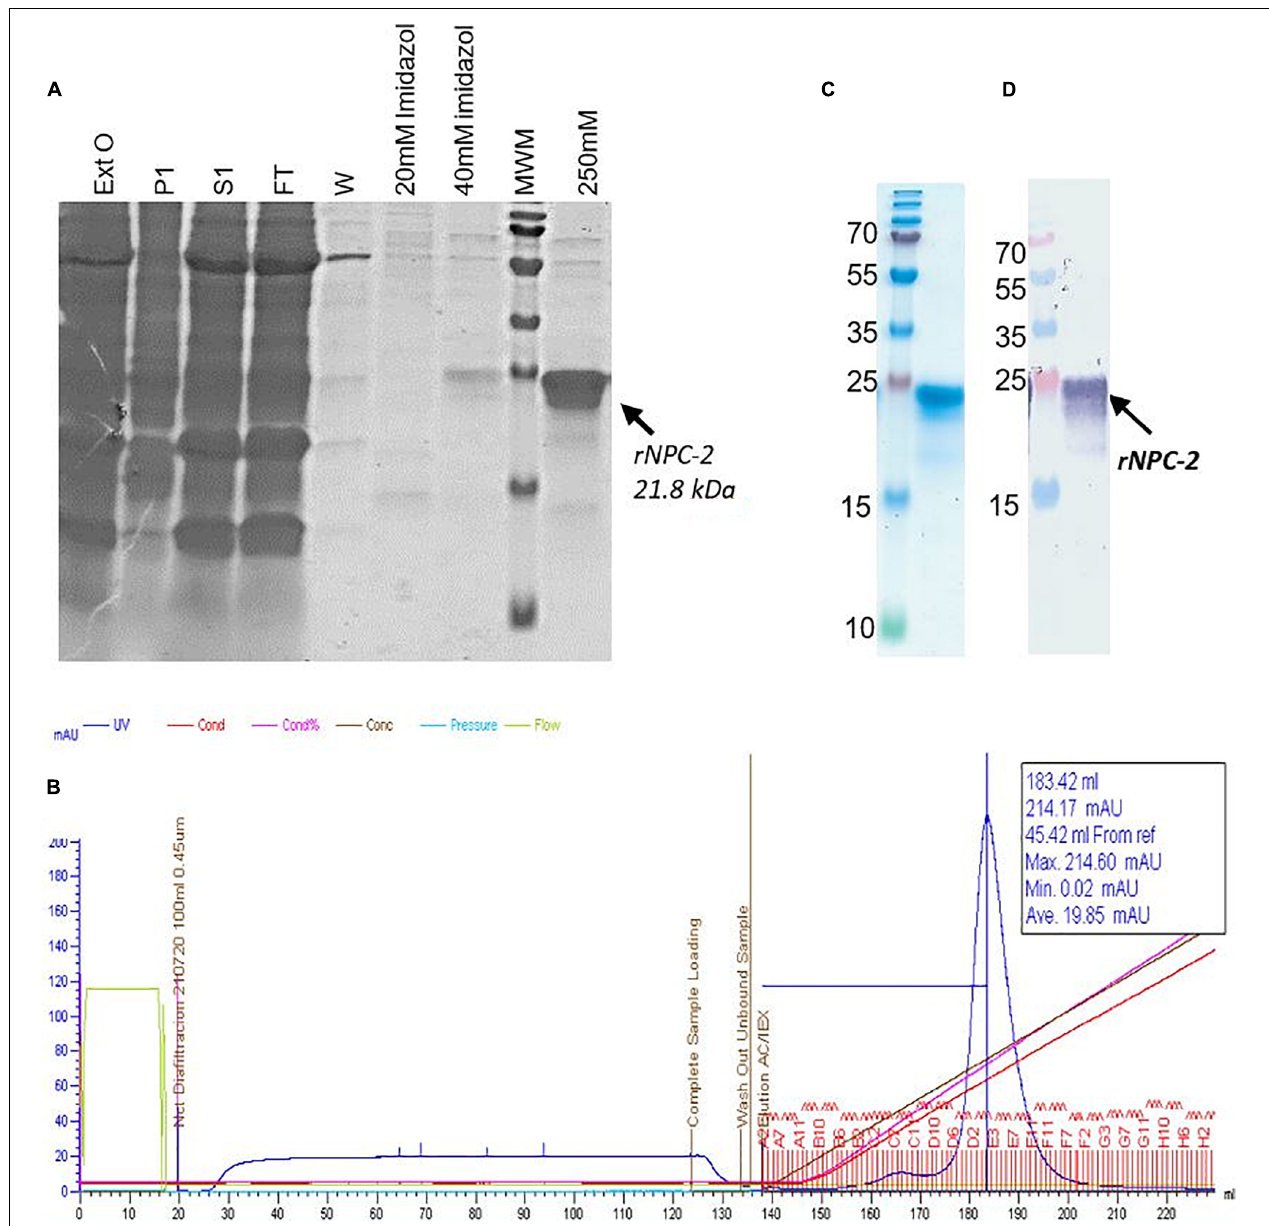
FIGURE 4 | Analysis of purified plant-produced recombinant NPC-2. See main text for details of the purification procedure. (A) Coomassie stained SDS-PAGE of Affinity Chromatography (IMAC-resin Ni2 + Sepharose Fast Flow). Fifteen µ l of: Ext-0 plant extract (Ext0), pellet (P1), soluble plant extract (S1), FT flowthrough (FT), washed (W) and imidazole gradient (20, 40, and 250 mM) were loaded. The NPC-2 protein was eluted with more than 80% of purity and migrate in SDS-PAGE (reducing conditions) as a protein of 21.8 kDa. (B) Fractions recovered from Cation Exchange Chromatography, (Hitrap SP FF SP) corresponding to recombinant NPC2. (C) Final Purity of recombinant NCP2 obtained from NaCl gradient analyzed by SDS-PAGE stained with Coomassie Blue. (D) Western blot analysis of recombinant protein NCP2 identified by Nucleocapsid Polyclonal Antibody (Invitrogen PAS81794).